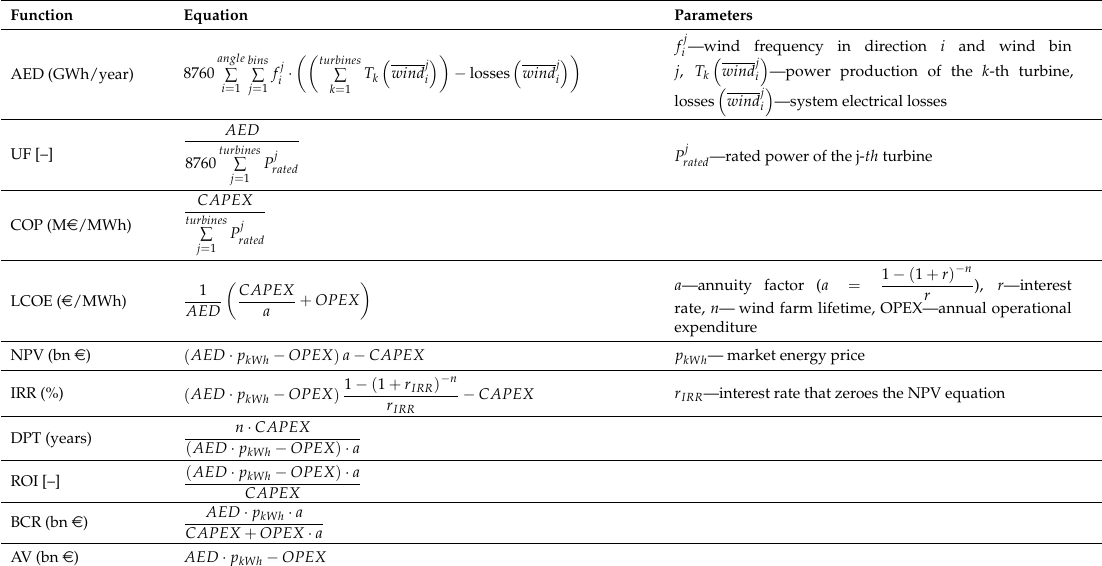
Table 3. Economic functions for the wind farm layout optimization problem (WFLOP)